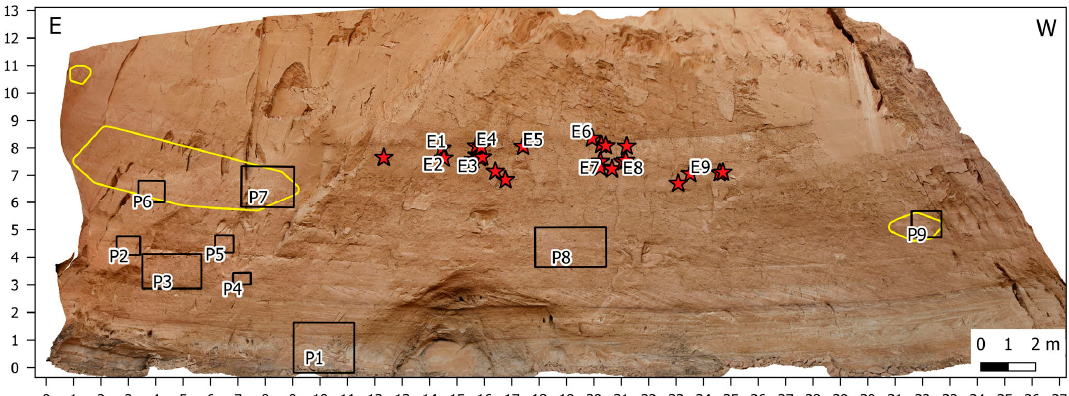
Figure 4. Orthophoto of the Nabara 2 shelter. The origin of the metric reference frame is set coincident with the eastern lower corner of the shelter. Stars indicate oval engravings; squares indicate painted compositions. Blobs bound major clusters of white cattle figures. Labels P1–P9 and E1–E9 refer to the engravings and art locations mentioned in the text.